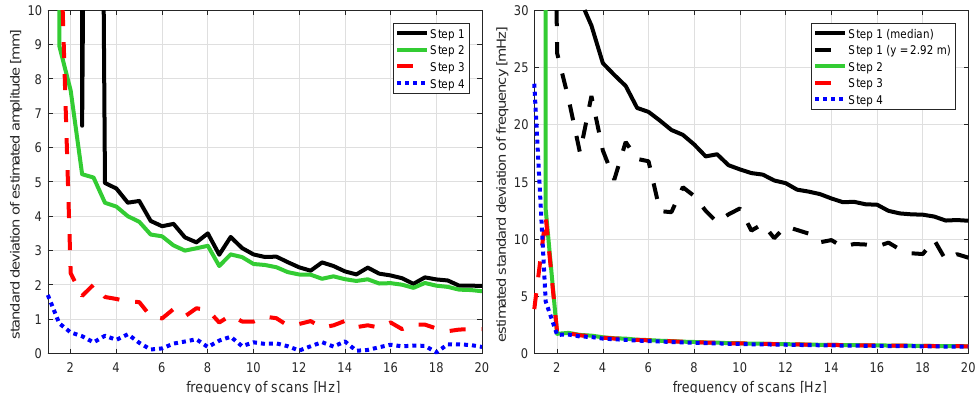
Figure 8. Results of set-up “sampling rate”: standard deviation of amplitude ( left ) and fre- quency ( right ). For reasons of clarity, the vertical axes are limited to 10 mm or 30 mHz, respectively, although larger values